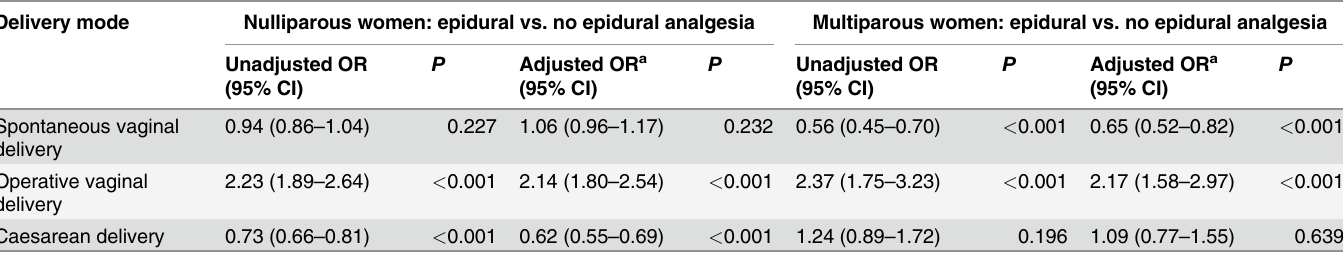
Table 5. Association between intrapartum use of epidural analgesia and different modes of